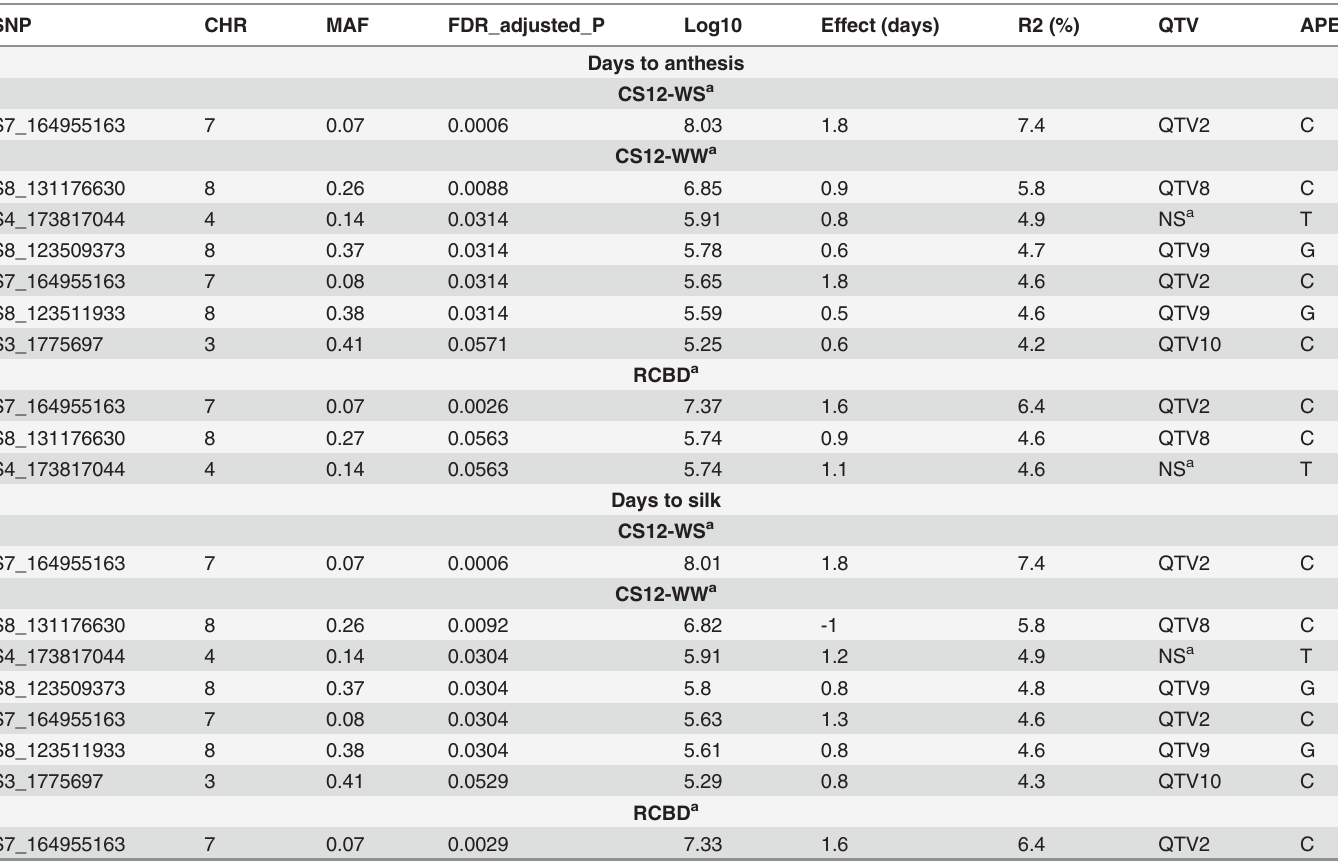
Table 11. GWAS results for days to anthesis and days to